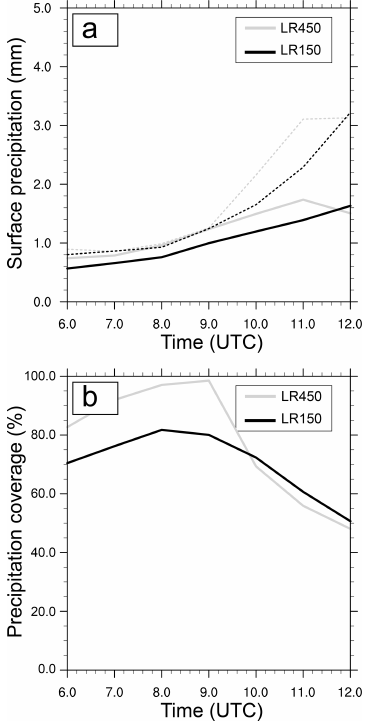
Figure 5. (a) Time series of the hourly surface precipitation (mm) for LR450 and LR150 experiment, averaged over the whole subdo- main seen in Fig. 4 (solid lines) and averaged over the area where surface precipitation exceeds 0.1mmh − 1 (dashed lines). (b) Time series of spatial coverage (%) of the hourly surface precipitation exceeding the threshold of 0.1mmh − 1 over the same